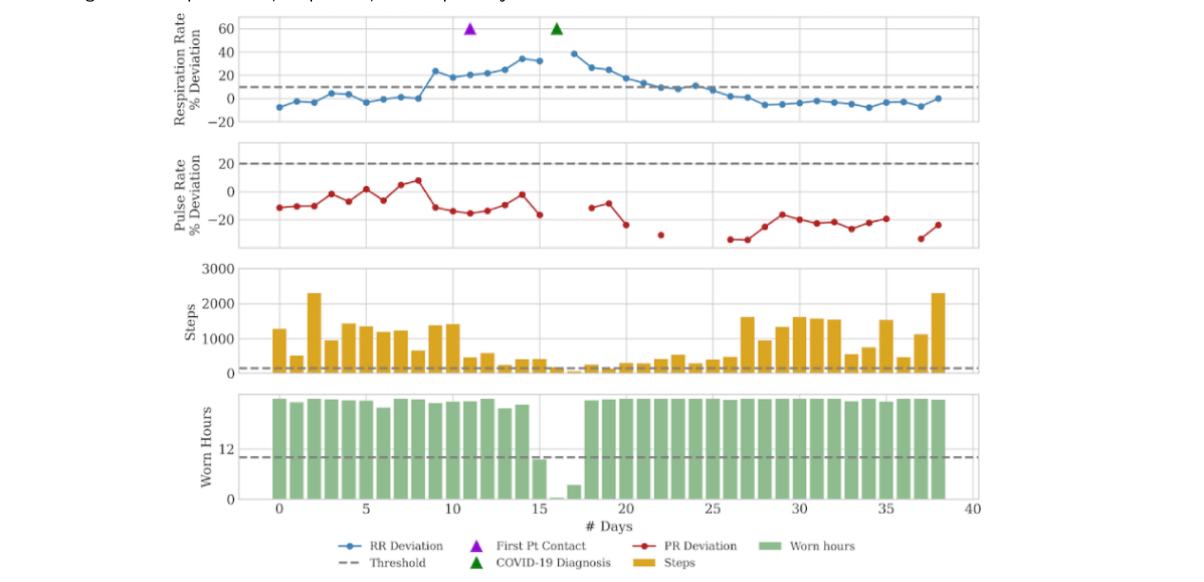
Figure 3. Daily physiology, activity, and adherence metrics for Case 3. Initial patient outreach based on RPM notification occurred 4 days before COVID-19 diagnosis. PR: pulse rate; Pt: patient; RR: respiratory